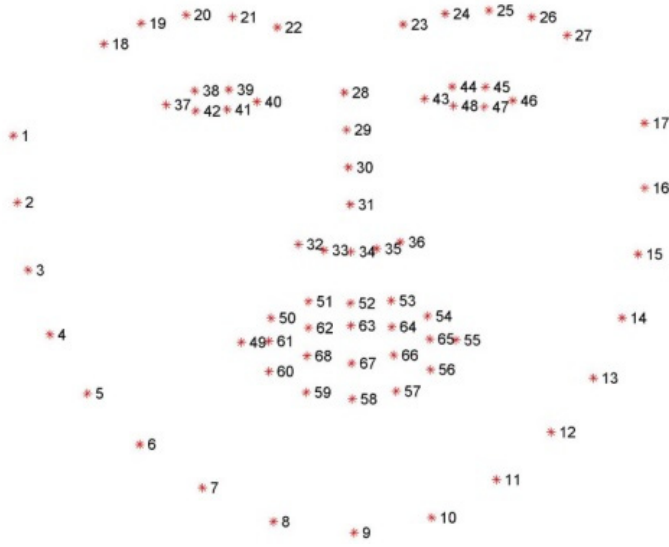
Figure 7. Sketch points of a face (landmarks) (own creation).